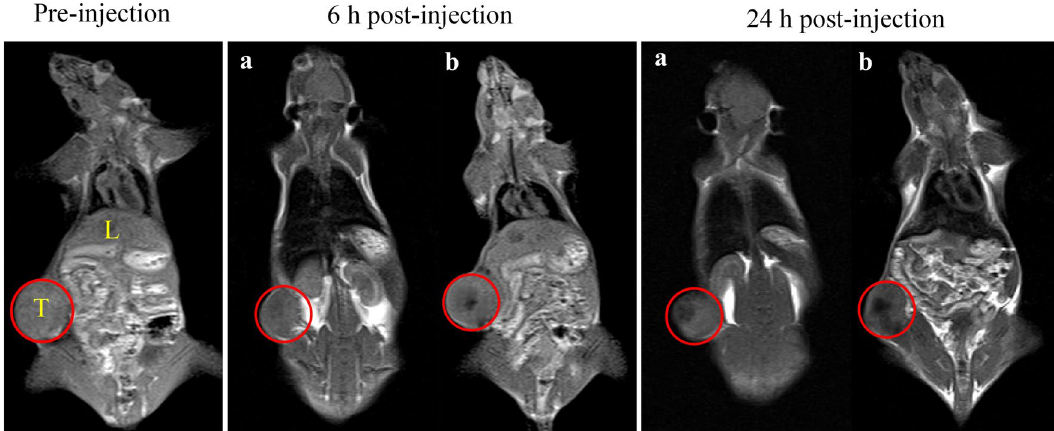
Figure 6. T1-weighted MR images of C26 tumor-bearing male BALB/c mice 6 and 24 h post-injection of ( a ) SPION/PVD and ( b ) SPION/PVD/MUC1 Apt /DOX (SPION equivalent concentration 0.6